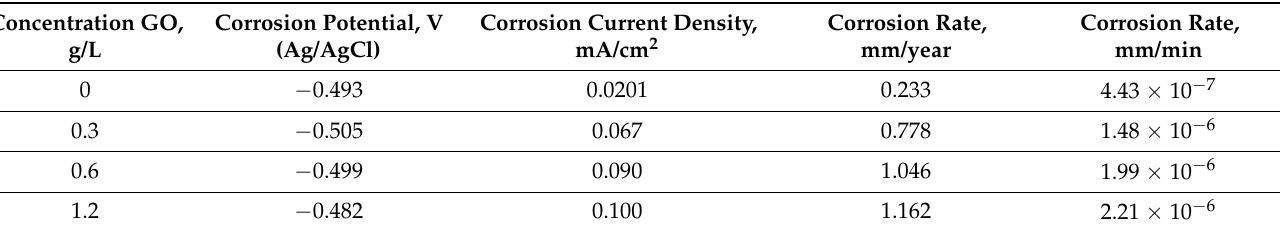
Table 6. Corrosion parameters determined from polarization curves in 0.1 M Na 2 SO 4 + 0.02 M H 2 SO 4